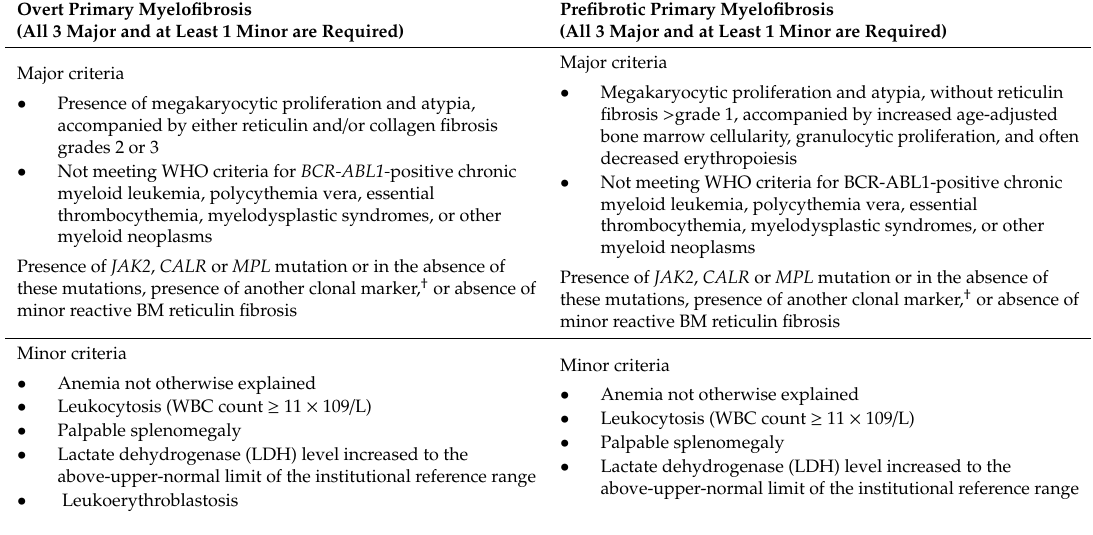
The revised 2016 World Health Organization (WHO) diagnostic criteria for primary